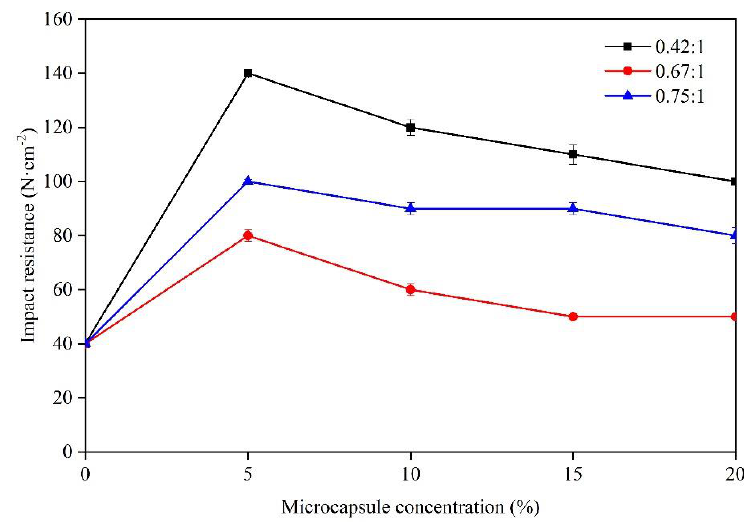
Figure 5. Effect of microcapsule concentration (0.42:1, 0.67:1, and 0.75:1 core-wall ratios) on adhesion.